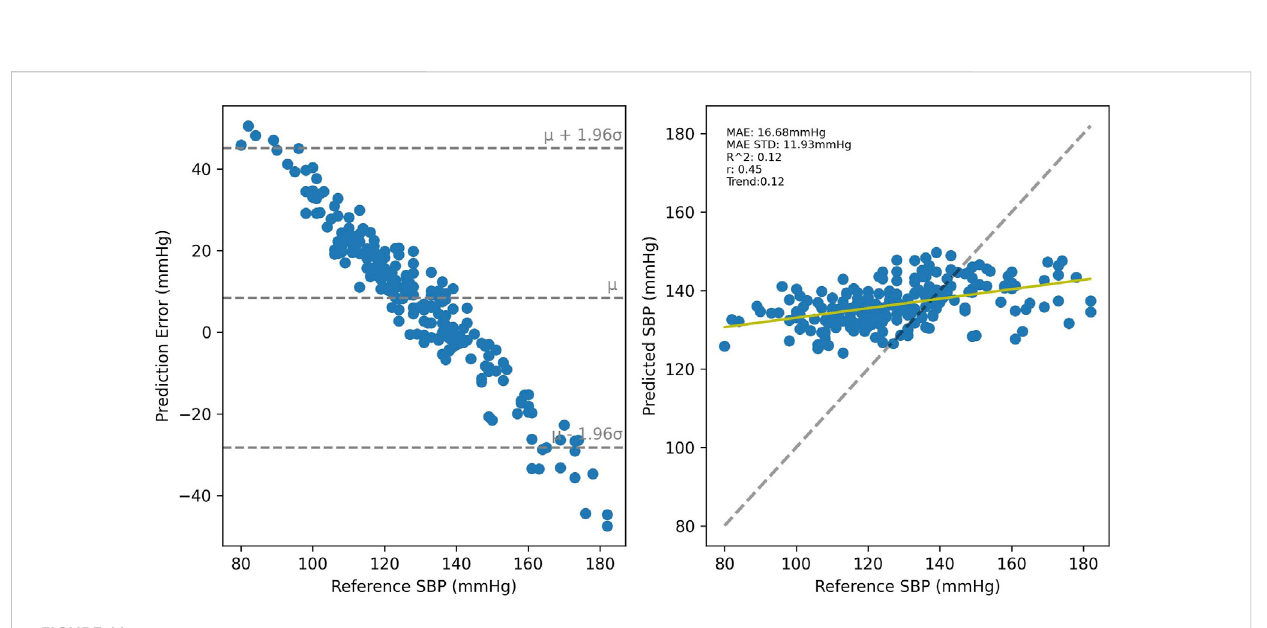
FIGURE 11 Results of the UCI trained model tested with the PPG-BP